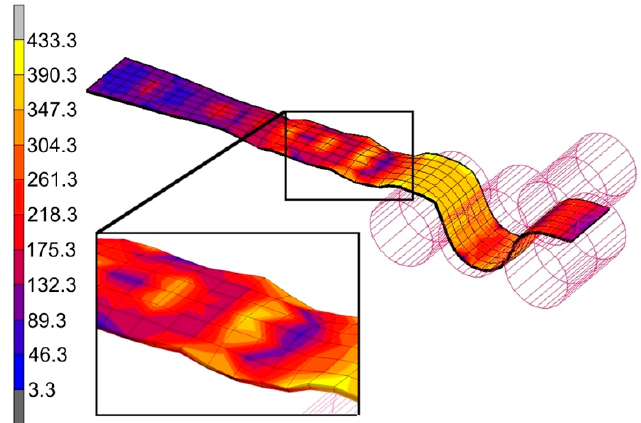
Figure 8. View of the mesh in the mesh sensitivity analysis (MSA).